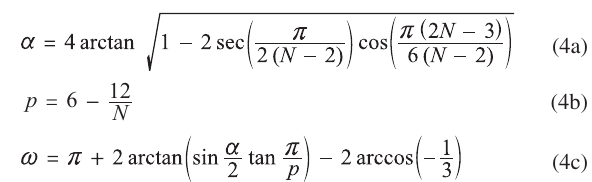
α , p and ω are given below as a function of the number of